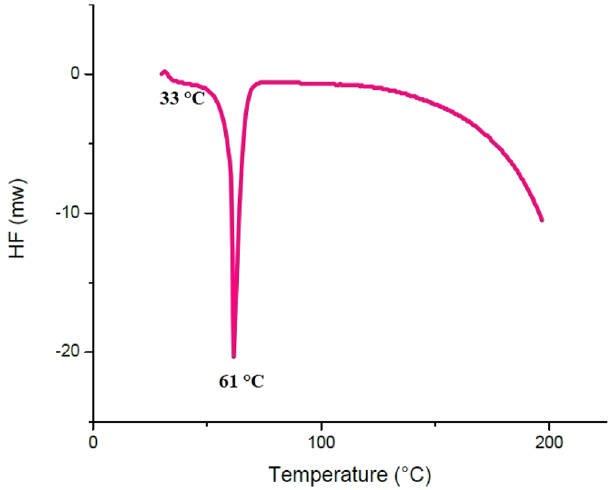
Figure 15. DSC diagram of difunctionalized PNIPAAM (M w = 4165 gr/mol).